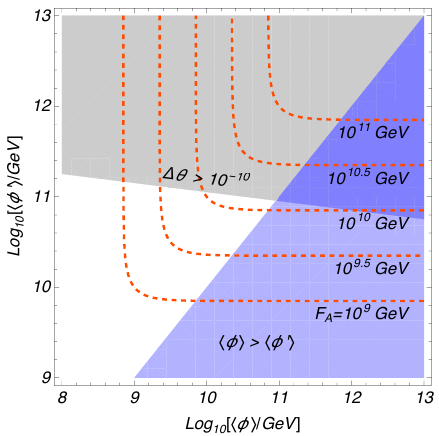
Figure 1 . The constraint on the VEVs of (cid:30) and (cid:30) 0 . The gray shaded region is excluded by (cid:1)(cid:18) < 10 (cid:0) 10 for the non-SUSY model (see eq. (3.16)). The orange lines are the contours of the e(cid:11)ective decay constant F A . In the blue shaded region, h (cid:30) i > h (cid:30) 0 i